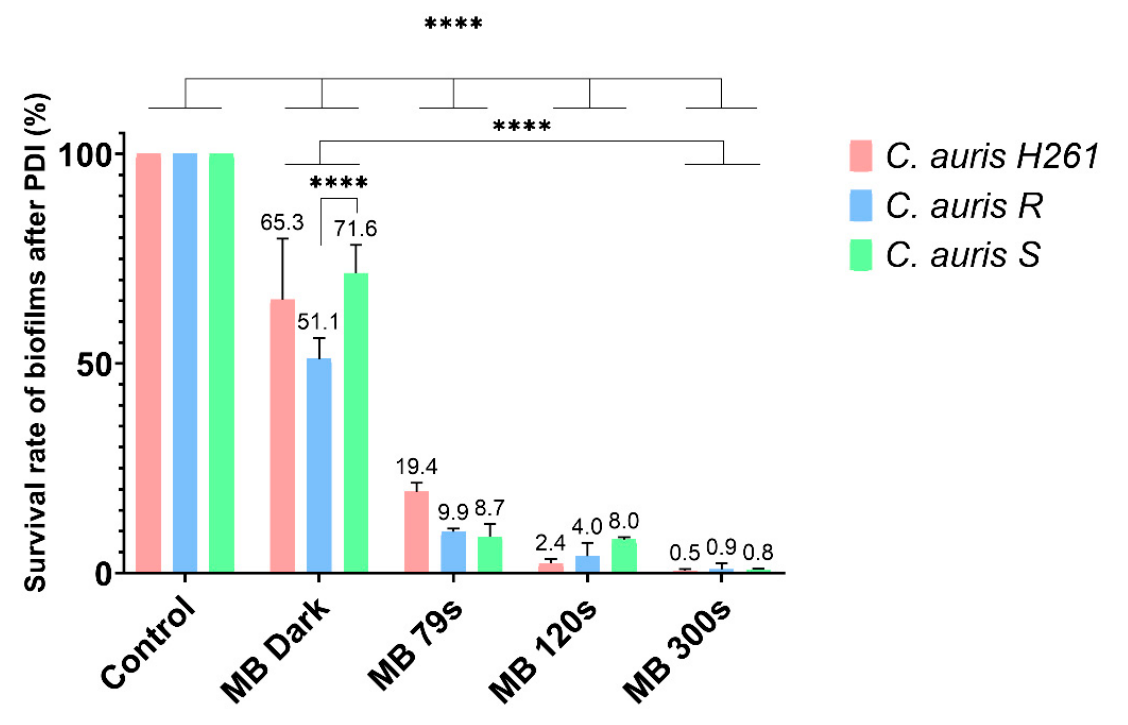
Figure 2. Effectiveness of PDI on C. auris H261, C. auris R, and C. auris S. The control group represents a 24 h biofilm without MB; the MB Dark group was incubated with 0.25 mM MB for 15 min. The MB 79 s, MB 120 s, and MB 300 s groups were irradiated for different periods after the initial 15 min